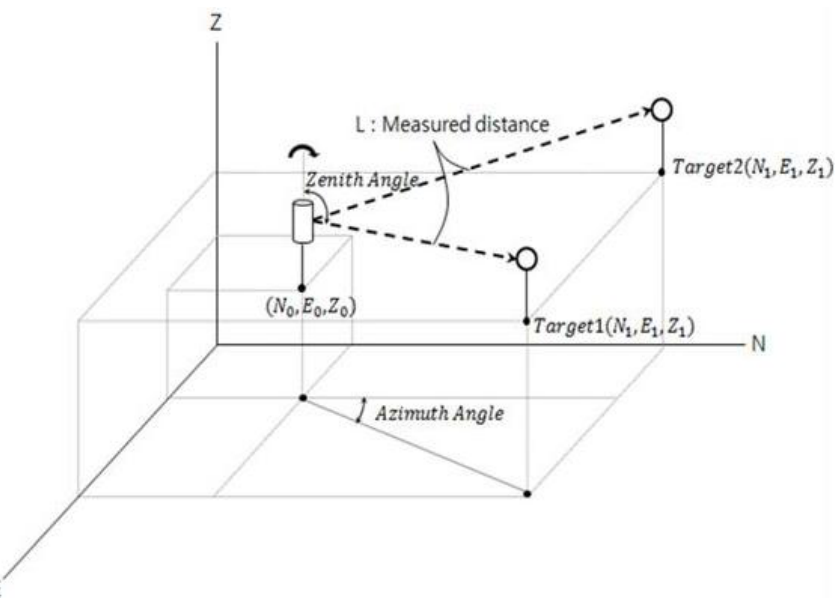
Figure 9. Measurement method of the total station.